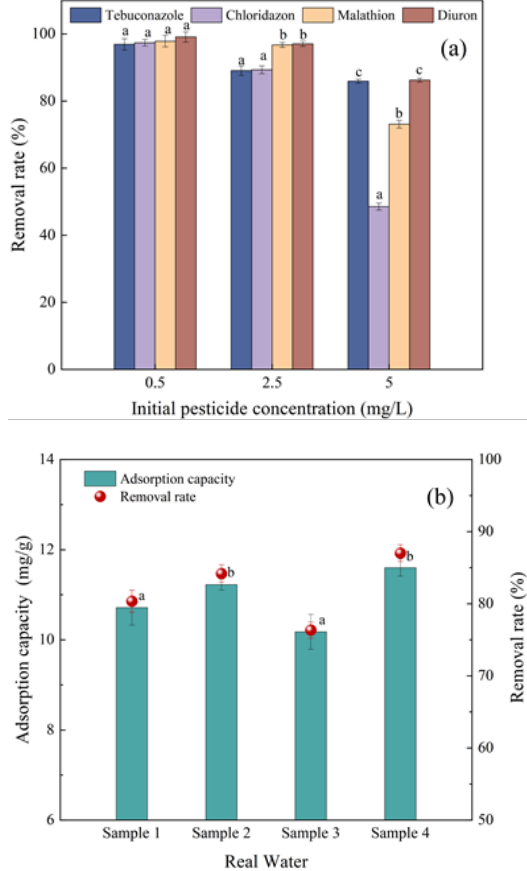
Figure 7. Adsorption capacity of SDMBC600 in mixed pesticide solution and real water sample: ( a ) mixed pesticides solution (tebuconazole, chloridazon, malathion, and diuron); ( b ) real water sample. (10 mg/L diuron, 0.075 g SDMBC600, t = 360 min). Different letters indicate significant differences between different treatments at the 0.05 level, testing by one-way ANOVA.